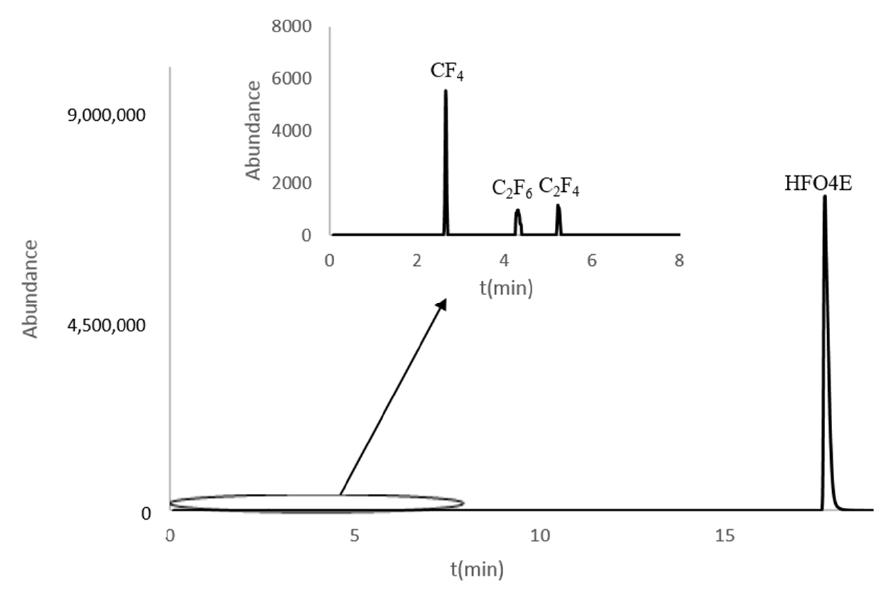
Figure 3. GC/MS chromatogram obtained for the gas mixture, 21.7% of HFO4E with N 2 , after making operations (100 × 24 kV − 630 A + 5 × 24 kV − 20 kA) in the medium-voltage switchgear.